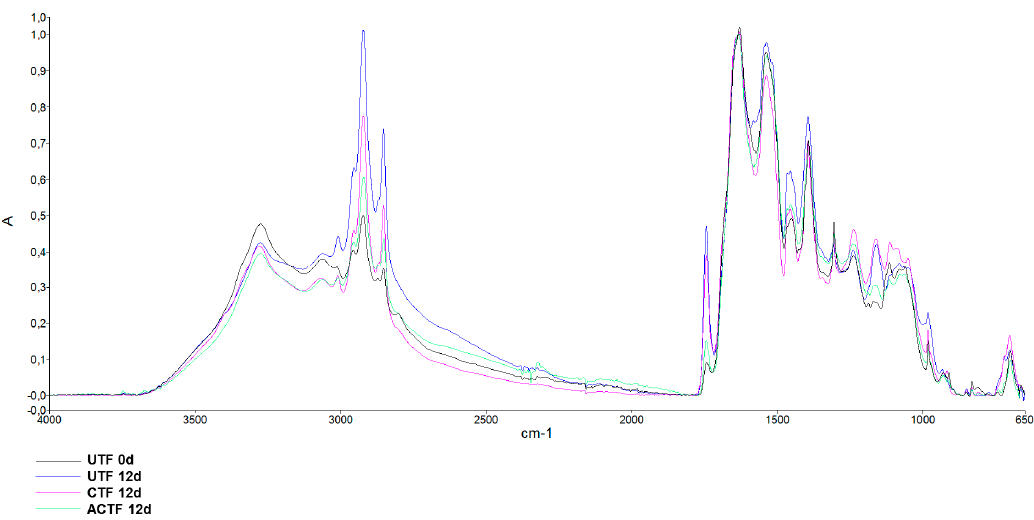
Figure 9. ATR-FTIR absorption spectra in the region 4000–650 cm − 1 of uncoated (UTF), coated (CTF), and coated with ELO (ACTF) trout fillets, after 12 days of storage at 4 ◦ C. The spectrum of trout fillet at 0 day is also shown. Spectra were baseline corrected and normalized for Amide I. Spectra are representative of three trout analyzed.